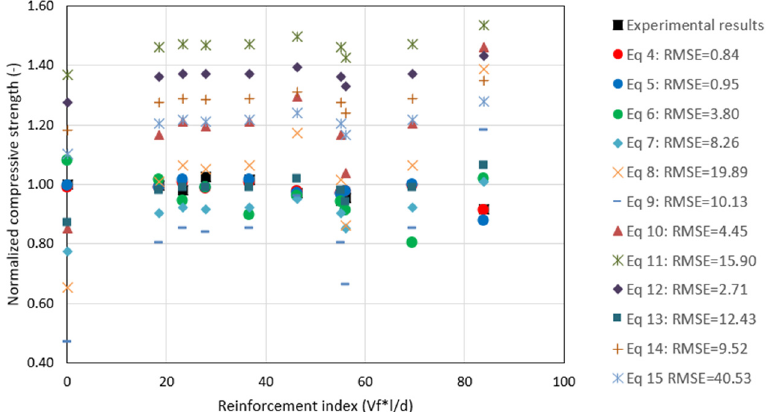
Figure 21. Histogram of the RMSE value with Pareto diagram for each equation.